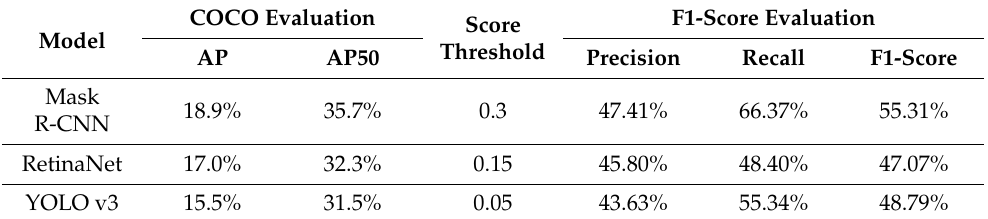
Table 2. Accuracy of the Test